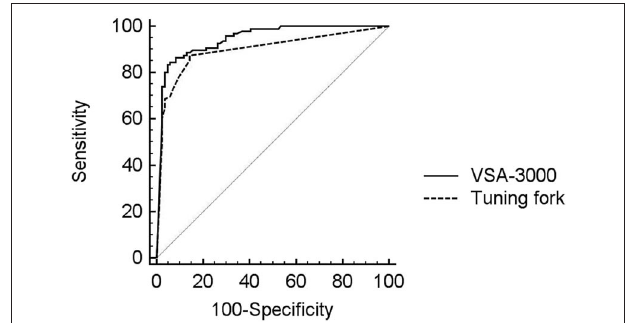
FIGURE 5 | ROC curve analysis was used to evaluate the diagnostic performance of VSA-3000 (black line) and tuning fork (dashed line) in detecting proprioception perception impairment against SSEP results using the evoked potential instrument. The gray line is the null value of the ROC curve.